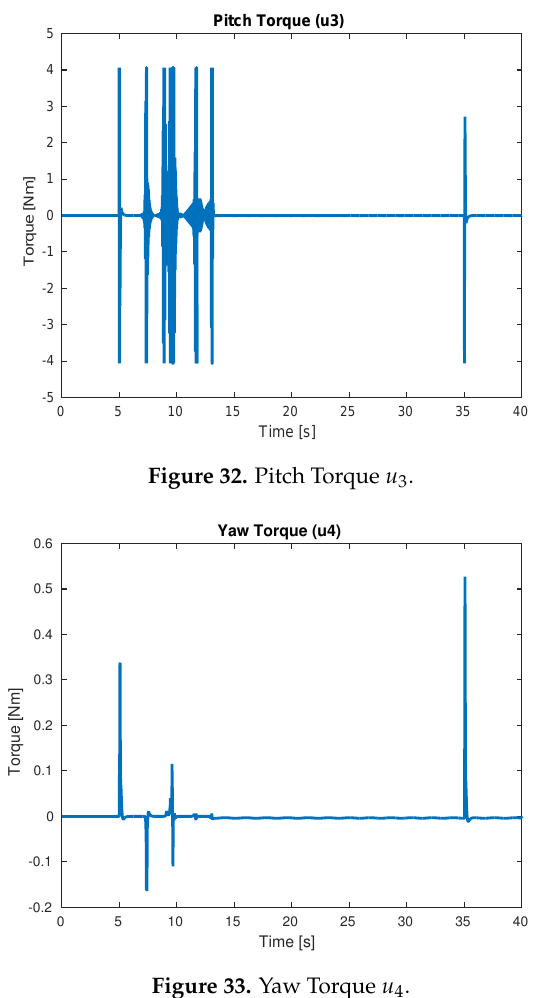
Figure 33. Yaw Torque u 4